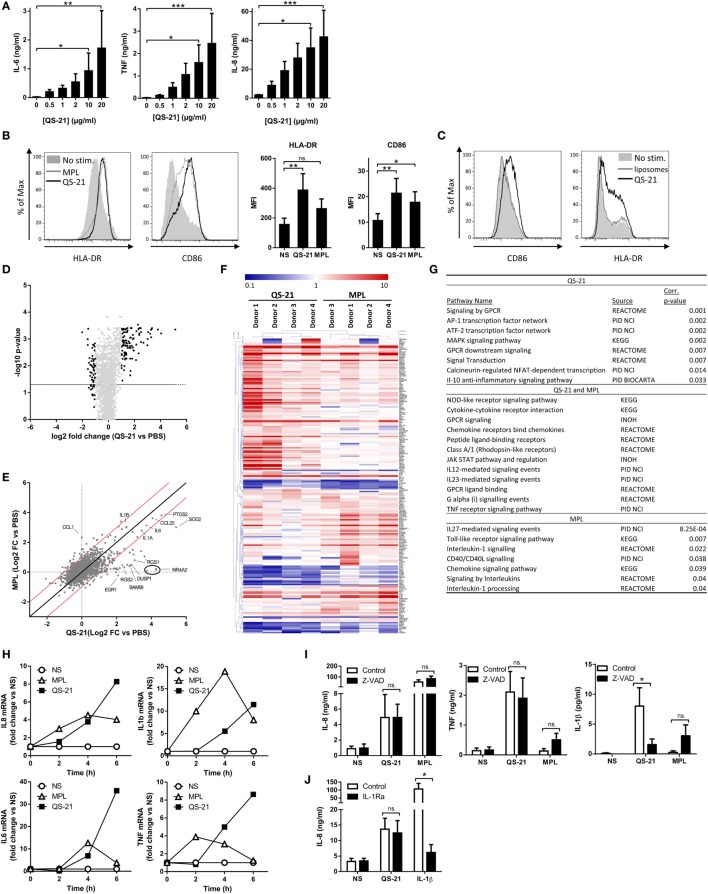
QS-21 directly activates human dendritic cells. (A) moDCs were stimulated with increasing concentrations of QS-21, and IL-6, TNF, and IL-8 were quantified in the culture supernatant after 24 h. Statistical significance was determined by a Friedman test followed by Dunn’s multiple comparisons. The means and SEM from four donors are shown. (B) moDCs were stimulated with QS-21 (10 µg/ml) or MPL (1 µg/ml) for 24 h, and surface marker expression was evaluated by flow cytometry. Representative histograms of HLA-DR and CD86 MFI and bar graphs representing the mean and SEM of cumulative data from eight donors are shown. (C) moDCs were stimulated with QS-21 (10 µg/ml) or liposomes for 24 h and CD86 and HLA-DR expression were evaluated by flow cytometry (D–F) moDCs from four donors were stimulated with QS-21 or MPL for 4 h and gene expression was analyzed by microarray. (D) Volcano plot of microarray data. Each point represents one gene plotted by log2 fold change (FC) vs. medium against −log10 of the p-value (average of four donors). The horizontal bar represents a p-value of 0.05. The light gray points represent genes with FC < 2 and FC > 0.5 and black points represent FC > 2 or FC < 0.5. (E) Scatter plot analysis of microarray data. Log transformed FC vs. medium of QS-21 is plotted against FC vs. medium of MPL (average of four donors). The dotted lines represent FC = 1, the solid black line represents FCQS-21 = FCMPL and the red lines represent a FCQS-21/FCMPL ratio of +2 or −2. (F) Hierarchical clustering and heatmap representation of differentially expressed genes (FC vs. medium >2 or <0.5) for the four donors. The color-coded scale representing fold change vs. medium (blue = downregulated vs. medium, red = upregulated vs. medium) is indicated at the top of the chart. (G) InnateDB analysis of pathway over-representation of significantly upregulated genes (p-value < 0.05 and fold change > 2) for cells stimulated with QS-21 (left) or MPL (right) using the hypergeometric algorithm and Benjamini–Hochberg correction for p-values. (H) moDCs were stimulated with QS-21 (10 µg/ml) or MPL (1 µg/ml) for the indicated durations, and IL-8, IL-1β, IL-6, and TNF transcript abundance was measured by qPCR. Data are from one donor representative of at least three independent experiments. (I) moDCs (n ≥ 5) were treated with Z-VAD-fmk (10 µM) and stimulated with QS-21 (10 µg/ml) or MPL (1 µg/ml), and IL-8, TNF, and IL-1β in the supernatant were measured by ELISA. (J) moDCs (n ≥ 5) were treated with recombinant IL-1 receptor antagonist (Anakinra—10 µg/ml) and stimulated with QS-21 (10 µg/ml) or IL-1β (10 ng/ml) and IL-8 was measured by ELISA. Statistical significance was determined by two-way ANOVA followed by Tukey’s multiple comparisons test.